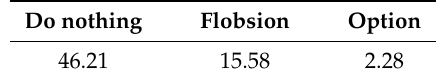
Table 2. Variance of the emission offsetting costs for the historical price distribution and